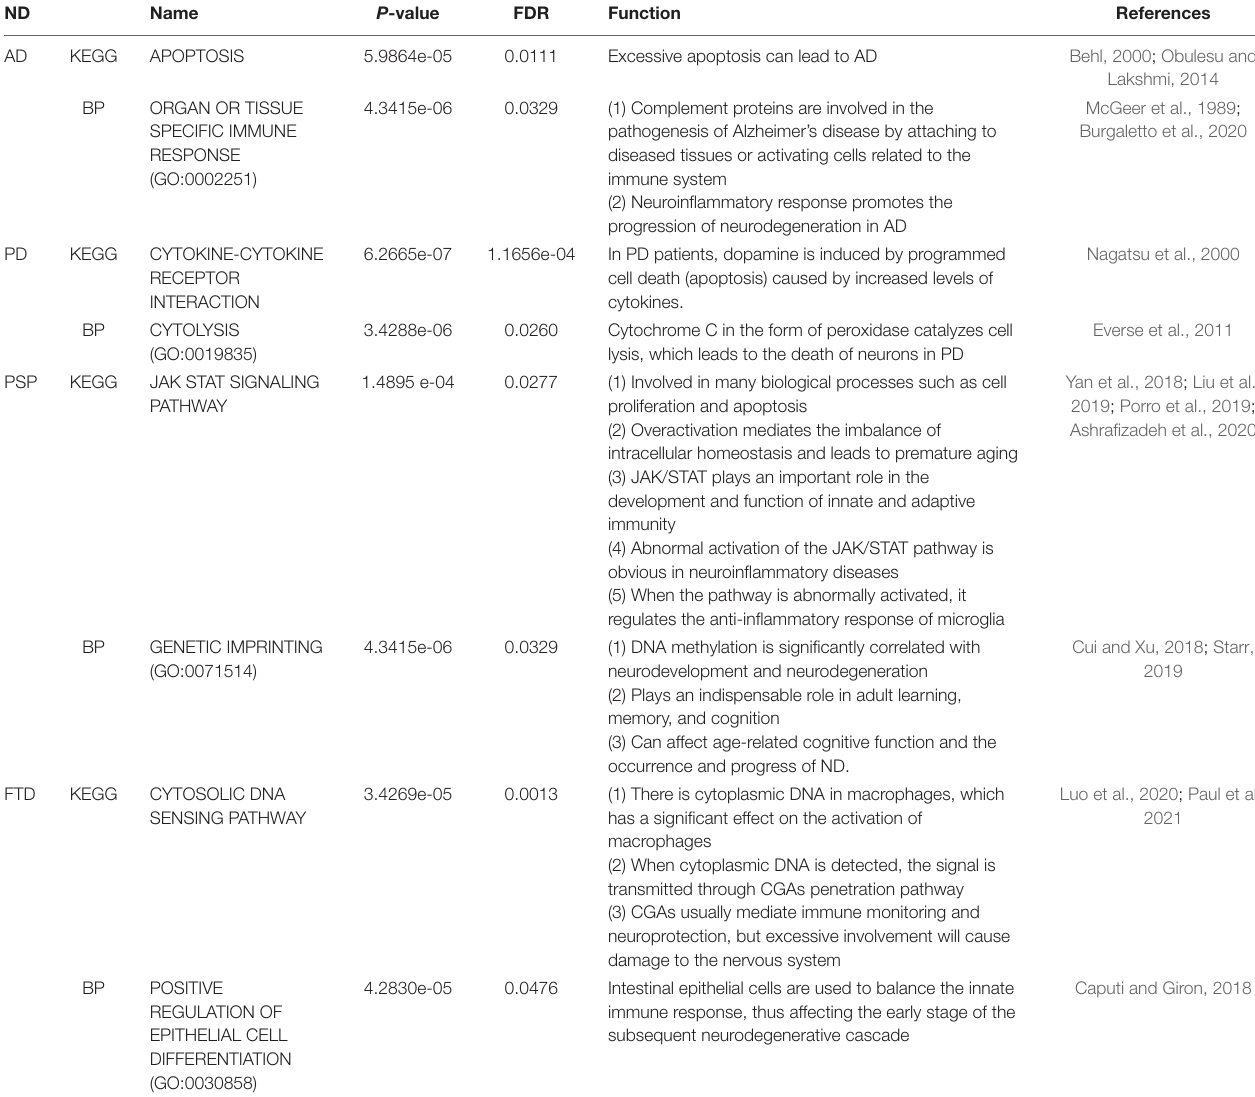
TABLE 5 | Enrichment analysis results (minimum p- value and FDR) of the four disease enrichment pathways are observed,